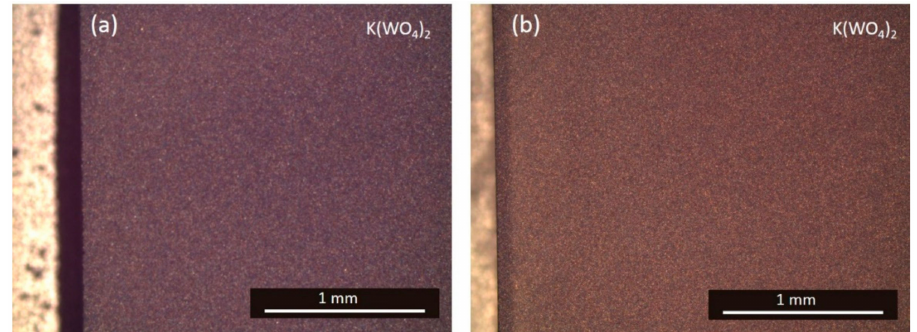
Figure 8. Microscope image of a KY(WO 4 ) 2 sample with ( a ) a medium and ( b ) a fine lapped surface